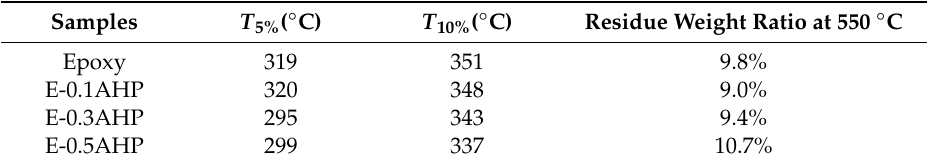
Table 5. TGA data of neat epoxy and AHP / EP